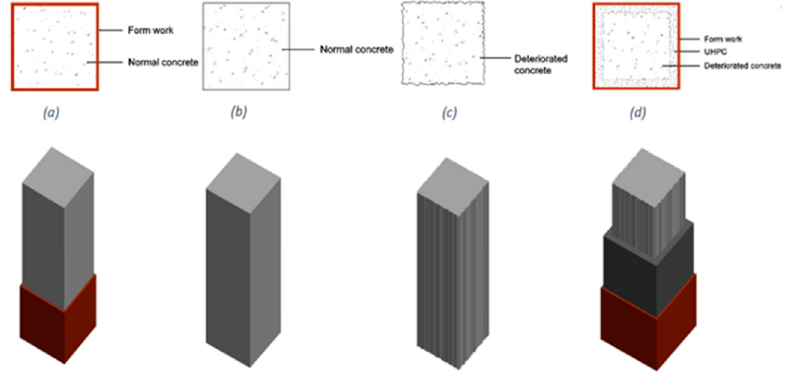
Figure 1. ( a ) Normal concrete casting, ( b ) Hardened NC after curing, ( c ) Deteriorated NC, ( d ) UHPC covered over deteriorated